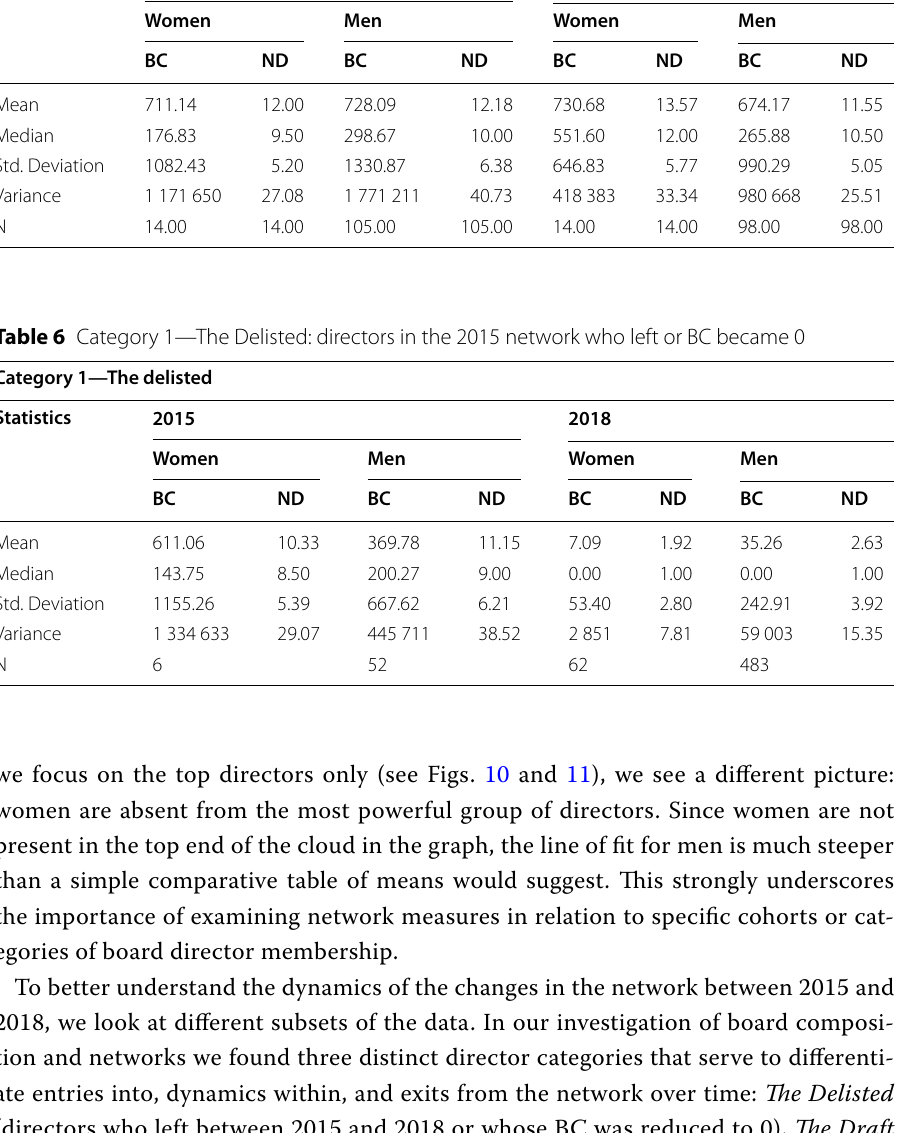
Table 5 Basic statistics for BC and ND by gender (2015 and 2018) Full network Statistics